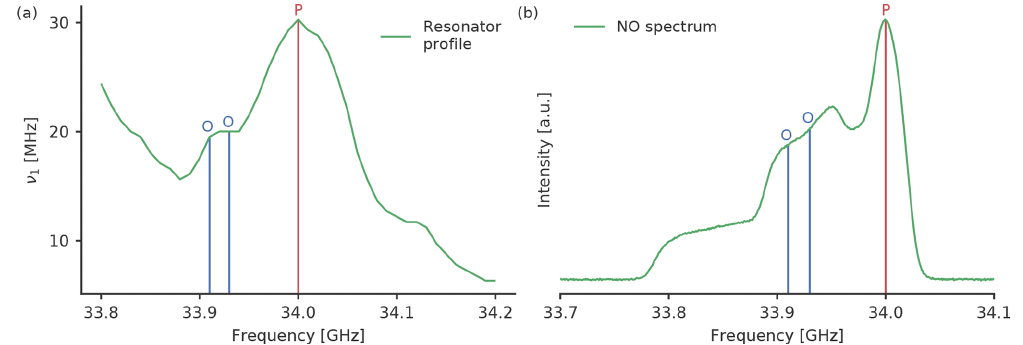
Figure 2. (a) Resonator profile with both tested observer frequencies (blue) and the pump (red) frequencies for the rectangular pulses and (b) the nitroxide spectrum with the positions of the two tested observer frequencies and the pump